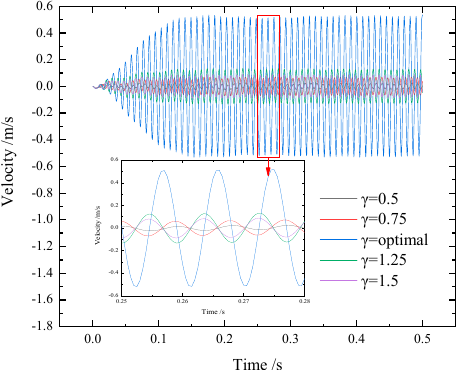
Figure 12. TMD system velocity time history curves at different tuning ratios.